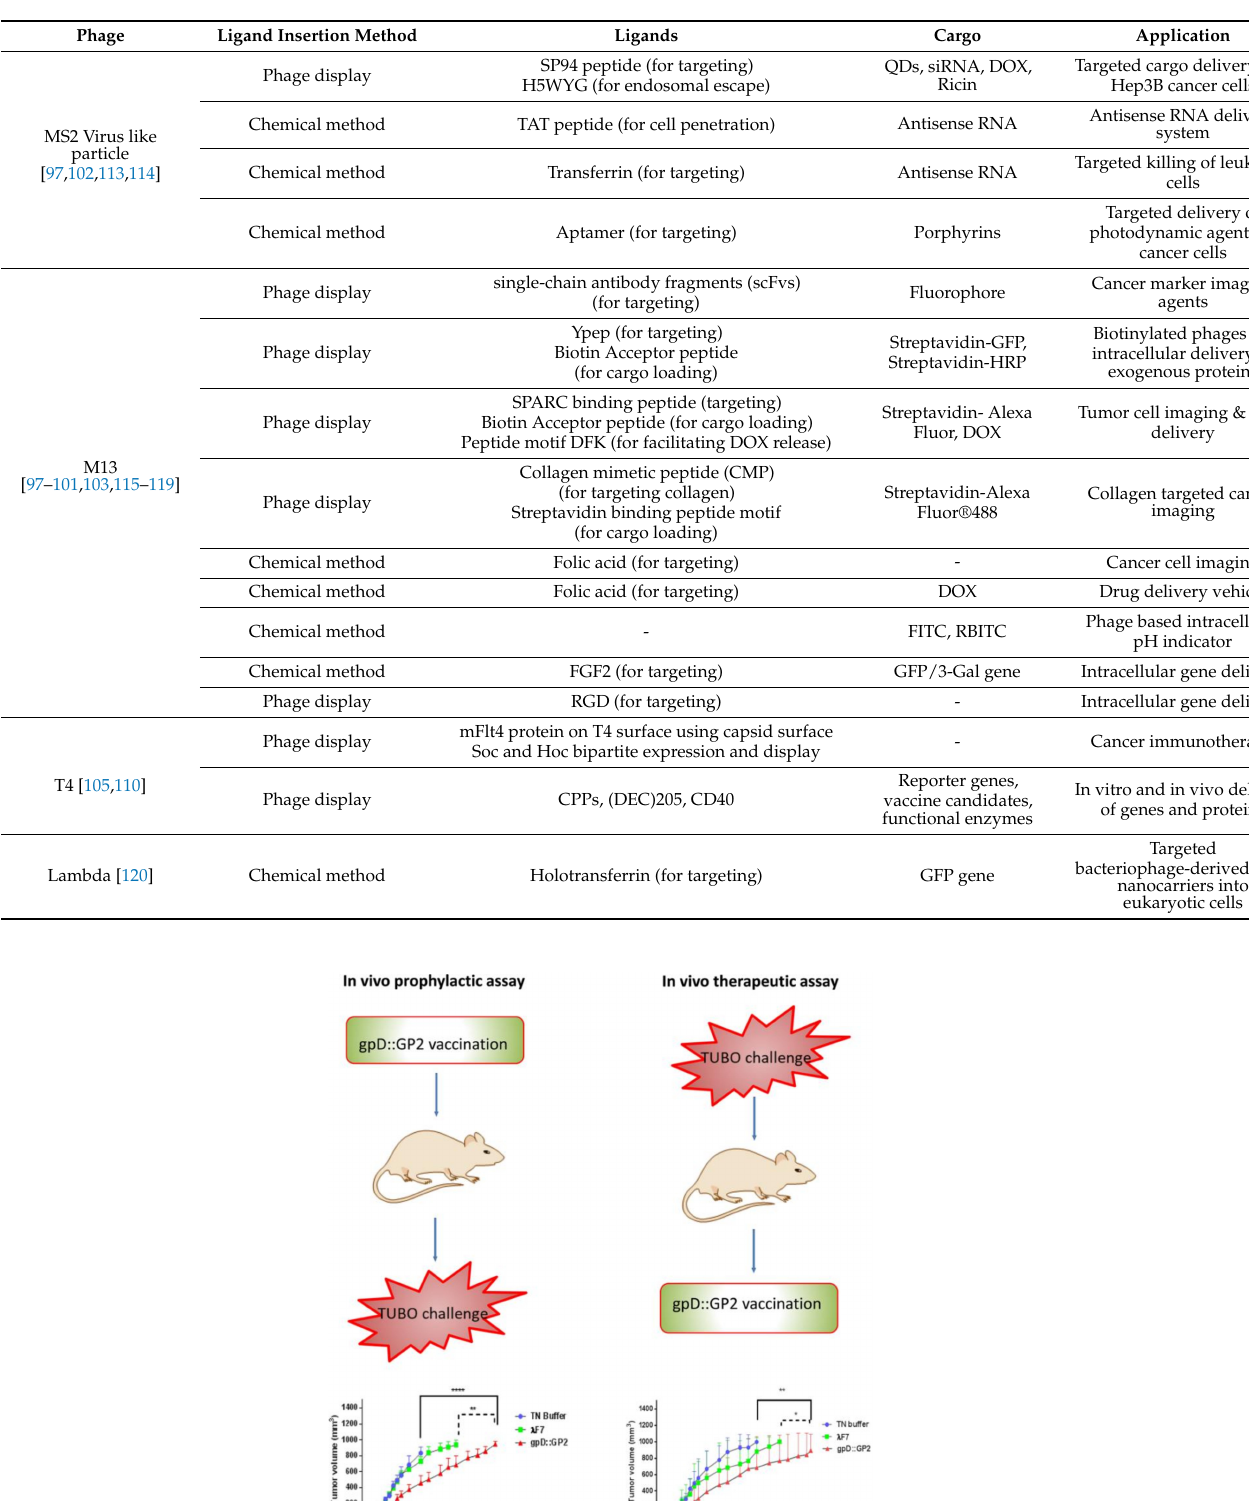
Table 1. List of phages utilized for cancer theragnostic.